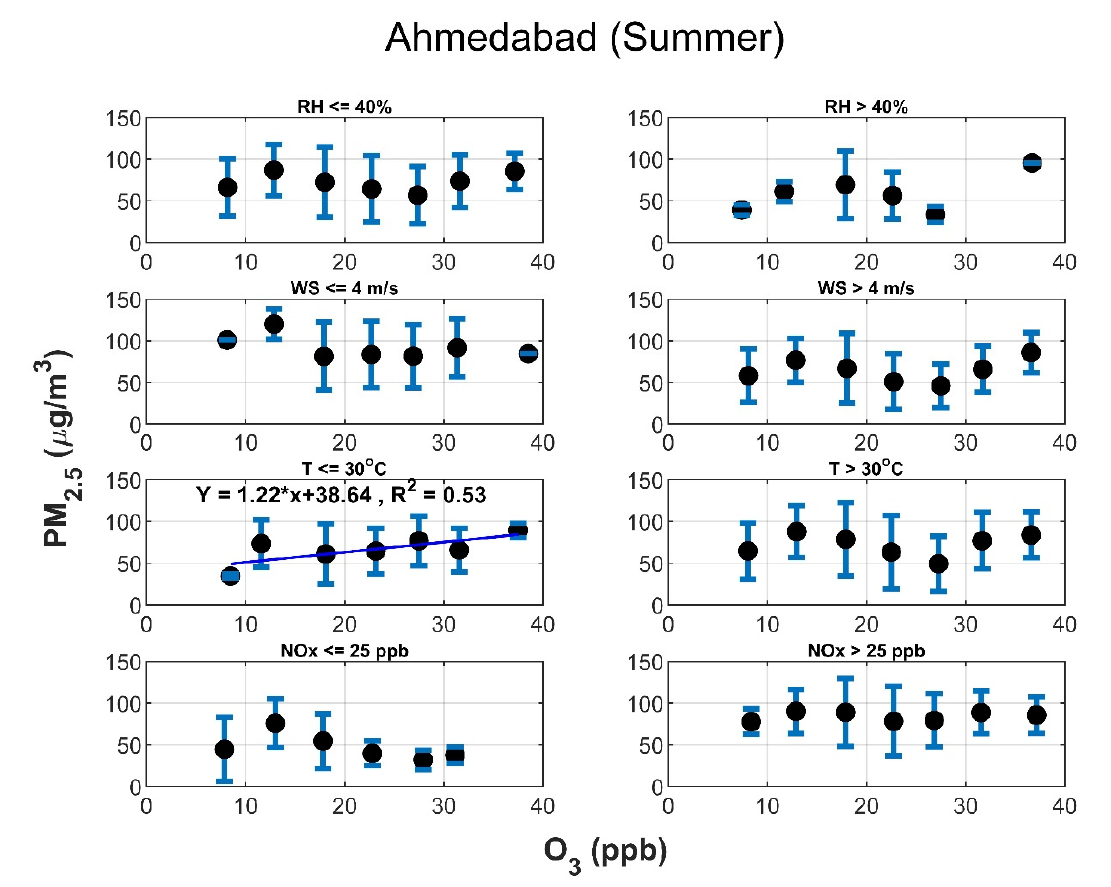
Figure 9. Dependence of PM 2.5 concentrations on O 3 in Ahmedabad during the summer season for different meteorological parameters.